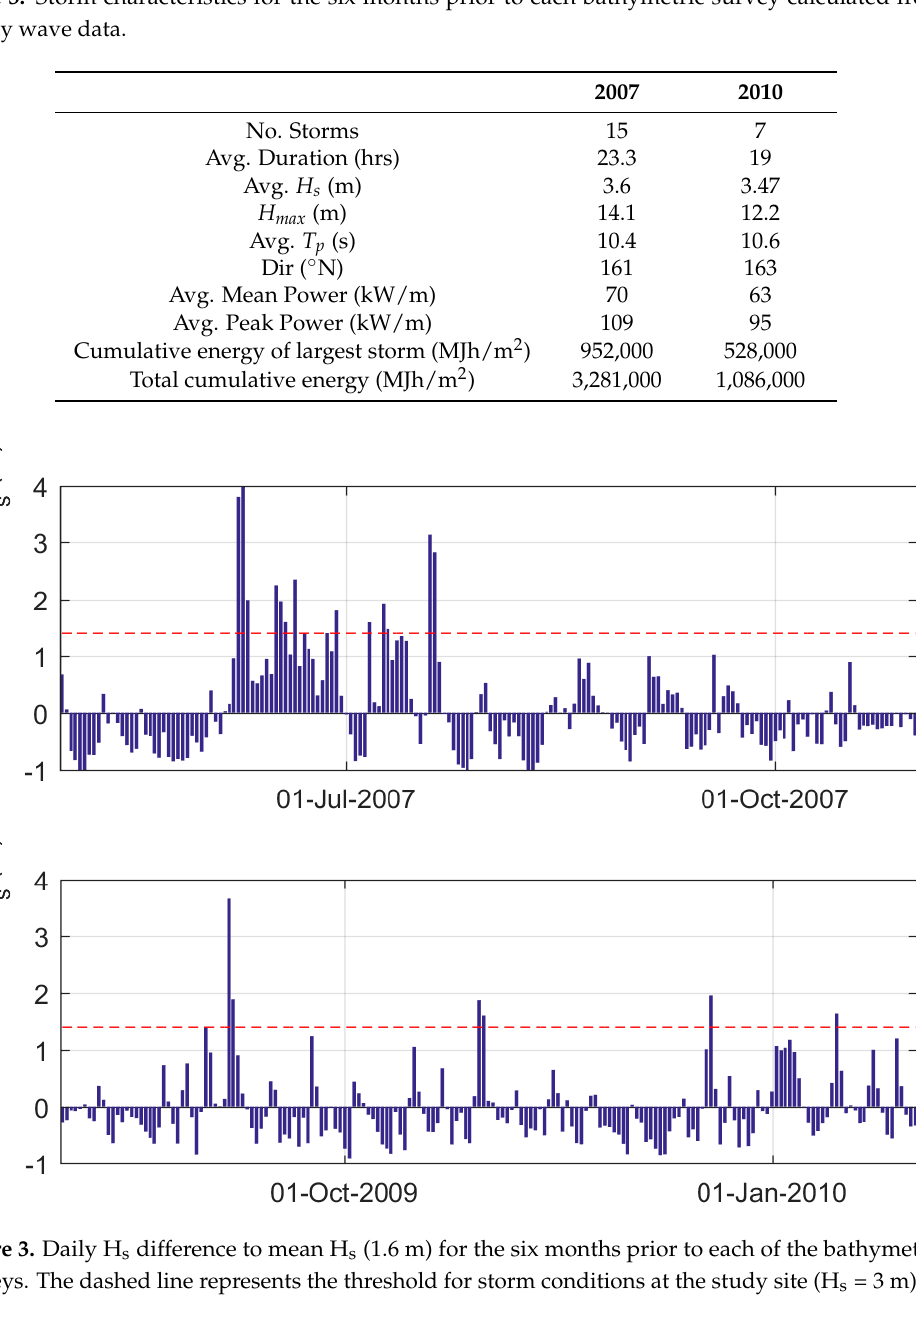
Table 3 . Storm characteristics for the six months prior to each bathymetric survey calculated from hourly wave data.